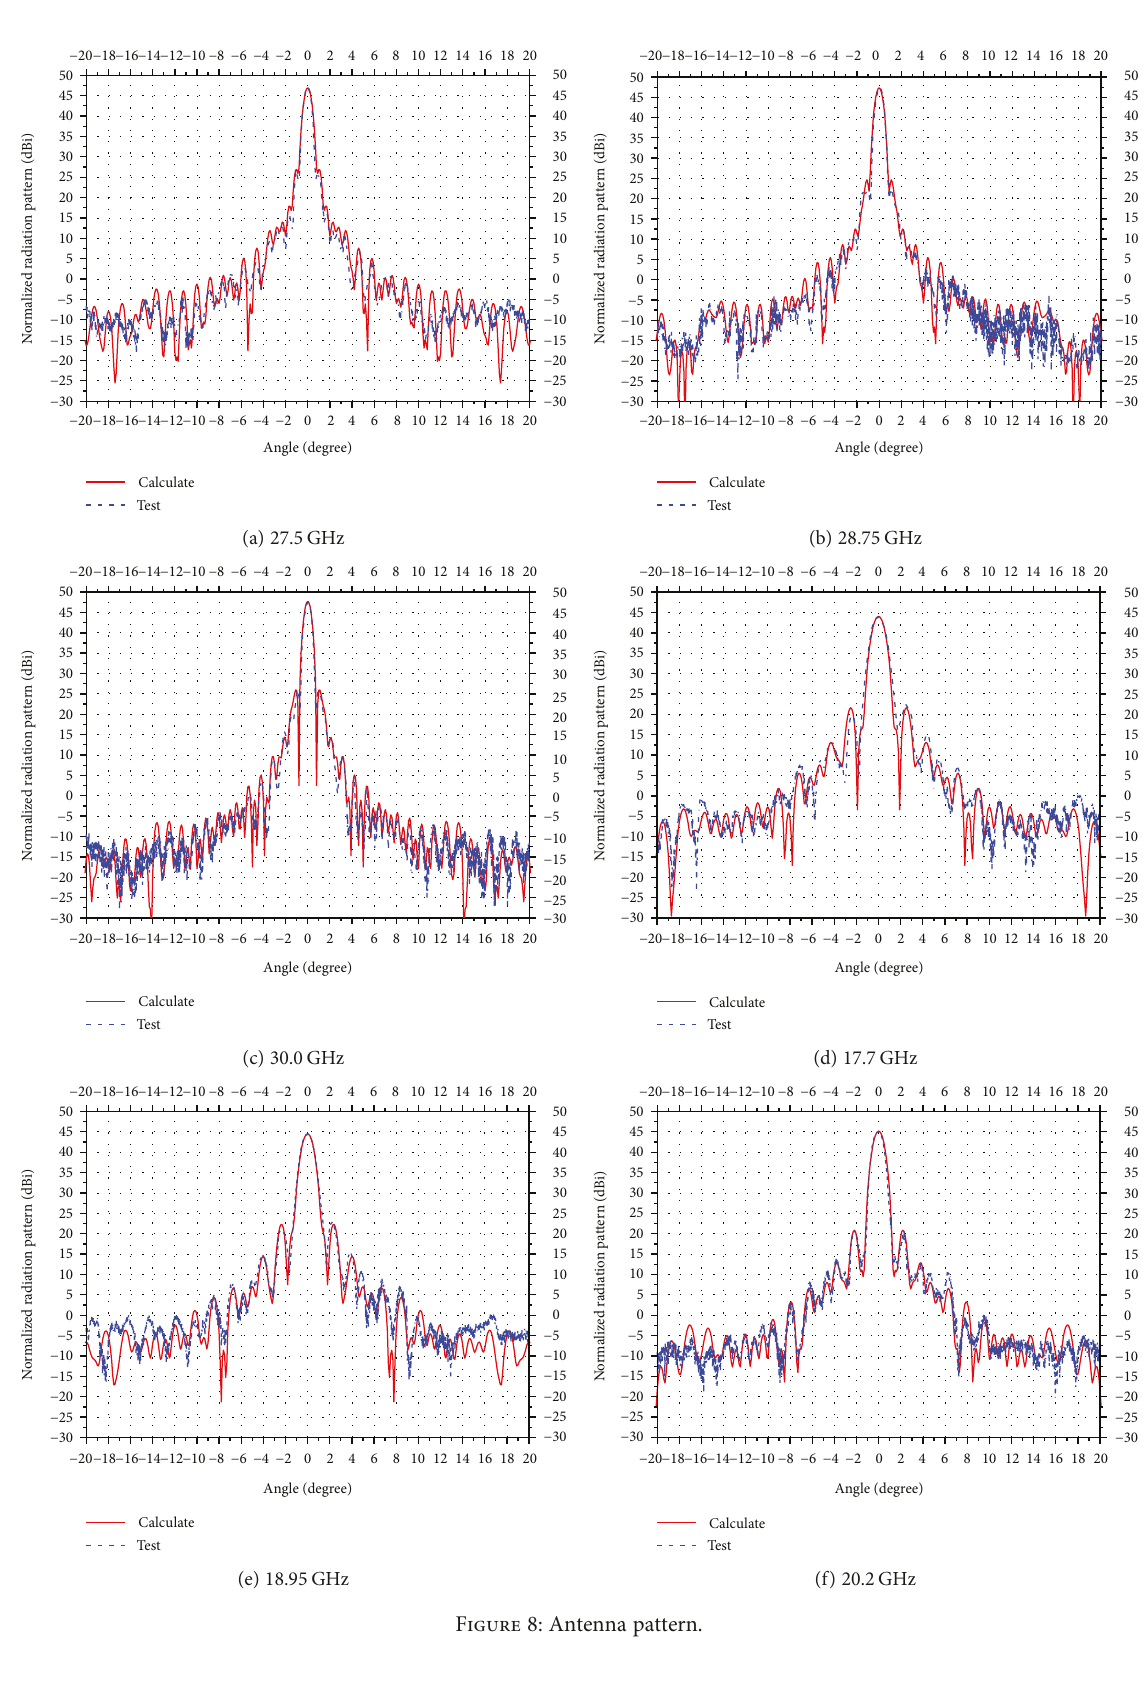
Figure 8: Antenna